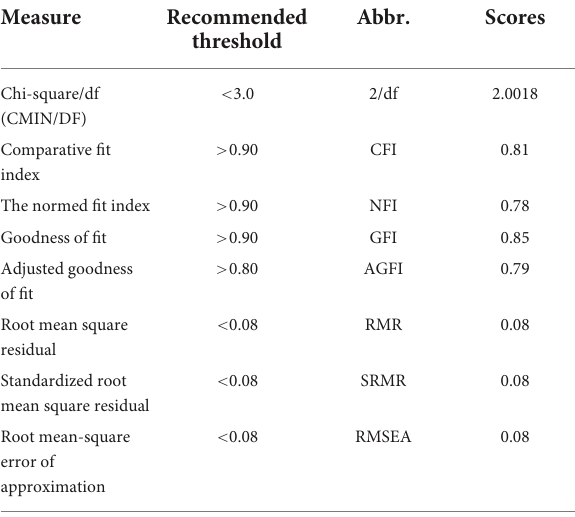
TABLE 3 Confirmatory factor analysis model.